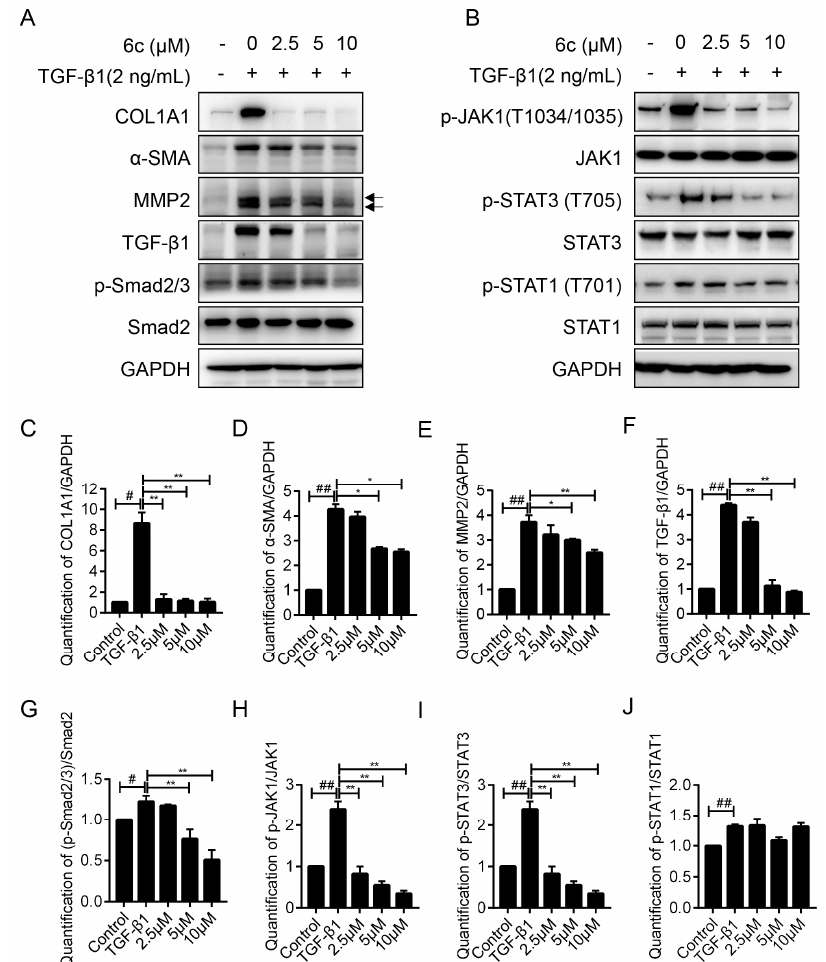
Figure 5. Inhibition effects of compound 6c (0 μ M, 2.5 μ M, 5 μ M, and 10 μ M) on fibrogenic markers, TGF- β 1/Smads pathway and JAK1/STAT3 pathway. ( A ) The protein expression levels of COL1A1, α -SMA, MMP2, TGF- β 1, p -Smad2/3, and Smad2/3 in LX-2 cells after treatment with the indicated concentrations of 6c together with TGF- β 1 (2 ng/mL) for 24 h were detected by western blot assay. ( B ) The protein expression levels of p-JAK1, JAK1, p-STAT3, STAT3, p-STAT1, STAT1 in LX-2 cells after treatment with the indicated concentrations of 6c together with TGF- β 1(2 ng/mL) for 24 h were detected by western blot assay. GAPDH served as internal reference. ( C – G ) Quantification of the intensities of COL1A1 ( C ), α -SMA ( D ), MMP2 ( E ), and TGF- β 1 ( F ) of (A). ( H–J ) Quantification of the intensities of p -JAK1 ( H ), p -STAT3 ( I ), and p -STAT1 ( J ) of ( B ). Data were presented as the mean ± SEM, # p < 0.05, ## p < 0.01 as compared to that of control group; * p < 0.05, ** p < 0.01 as compared to that of TGF- β 1 group.